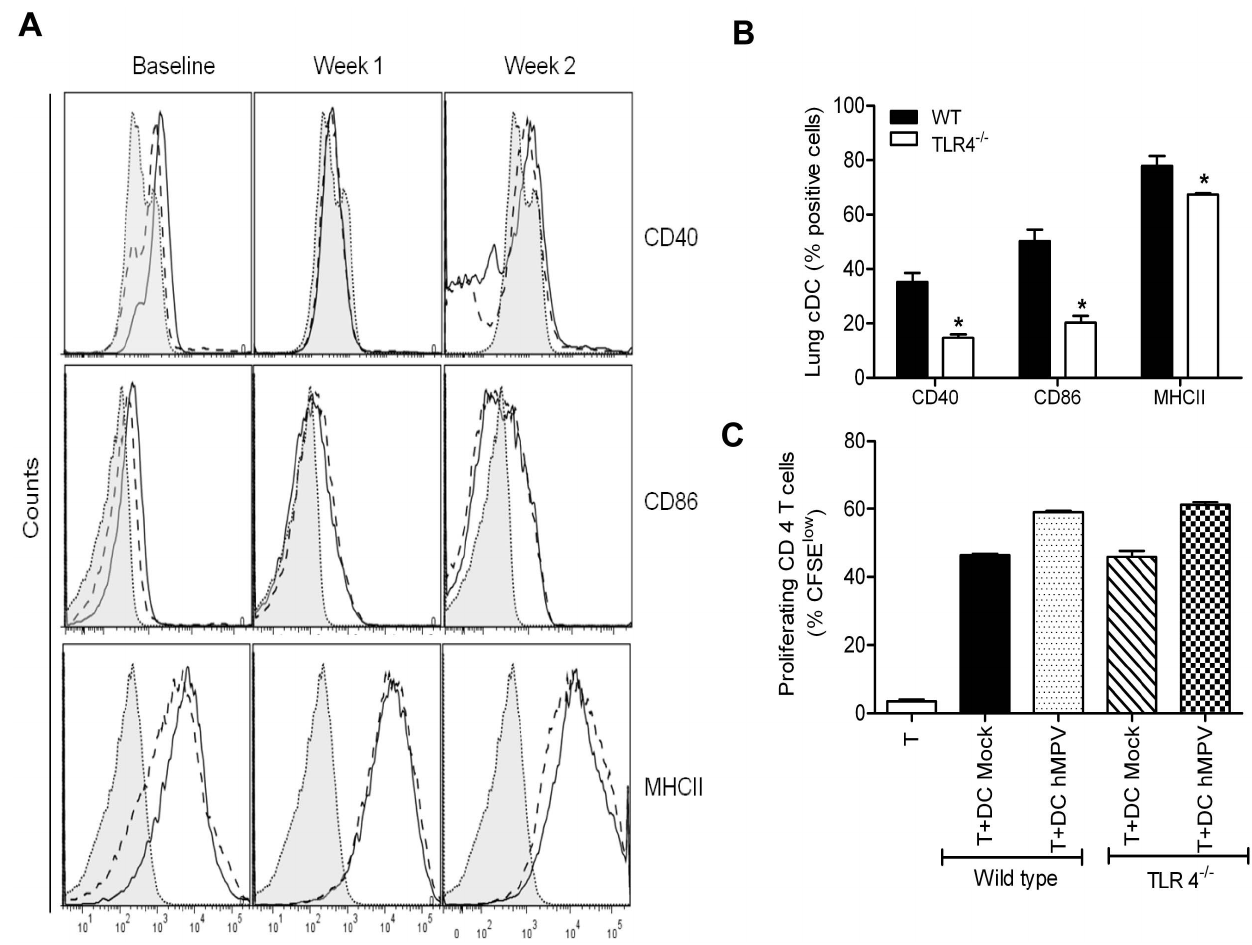
Figure 4. Lung dendritic cell characterization and lymphocyte proliferation in response to hMPV infection in TLR4 2 / 2 mice. TLR4 2 / 2 and WT mice were mock- or hMPV-infected, and sacrificed at week 1 and 2 p.i. to collect lungs. Single cell suspension was obtained and cDCs population enriched using CD11c-tagged magnetic beads isolation. CD40 and CD86 markers were analyzed in cells positive for CD11c and MHC-II by flow cytometry. Histograms showing the expression of costimulatory molecules (CD40, CD86 and MHCII) in cDC from WT mice (open histograms) and cDC from TLR4 2 / 2 mice (dashed line open histograms), and isotype control (shaded histograms), are shown ( A ). Graph of baseline expression of costimulatory molecules in lung dendritic cells isolated from WT and TLR4 2 / 2 mice ( B ). Dendritic cells (CD11c positive cells) were isolated from lungs of hMPV or mock-infected mice either WT or TLR4 2 / 2 at day 7 p.i. and loaded with 10 m g/mL of OVA peptide for 2h prior to coculture with T cells. CD4 + T cells isolated from spleen of OT II mice were labeled with CFSE and cocultured with DCs at a ratio of 1:2 (DC: T). T cell proliferation was measured by CFSE dilution (proliferating CD4 + cells have a lower CFSE intensity than non-proliferated control cells). Cultures without antigen served as controls. The bar graph shows the percentage of proliferating (CFSE low ) T cells among the total CD4 + T cell population. Data are expressed as mean 6 SEM of four mice/group and represent one of two independent experiments ( C ).